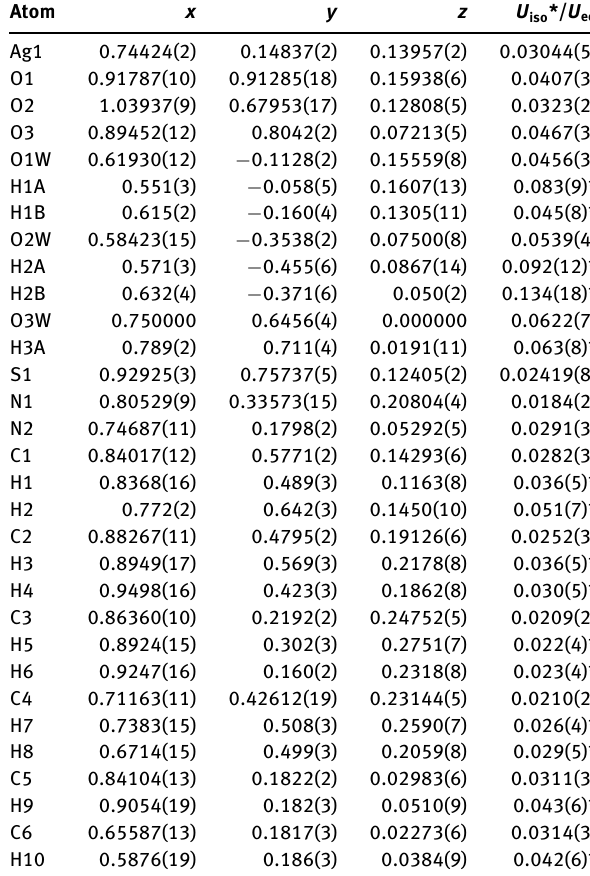
Table 2: Fractional atomic coordinates and isotropic or